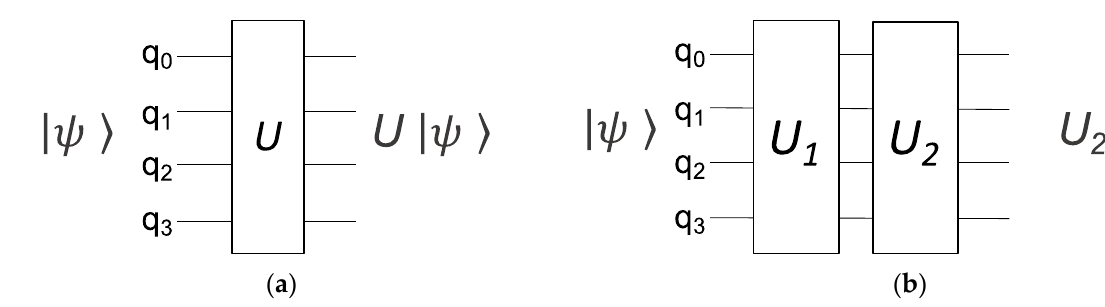
Figure 4. ( a ) Module a simple gate. ( b ) Module with two sequential gates.